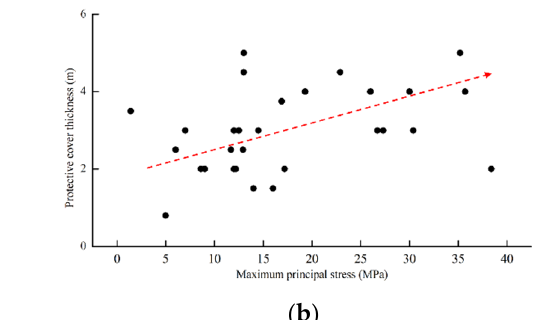
Figure 18. Statistics of excavation procedures at the high side wall zone. ( a ) The usage proportion of excavation procedures. ( b ) In situ stress distribution of excavation procedures.